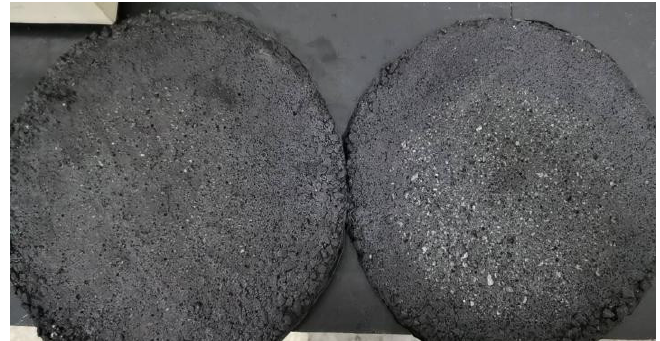
Figure 4. Wet wheel wear resistance test.